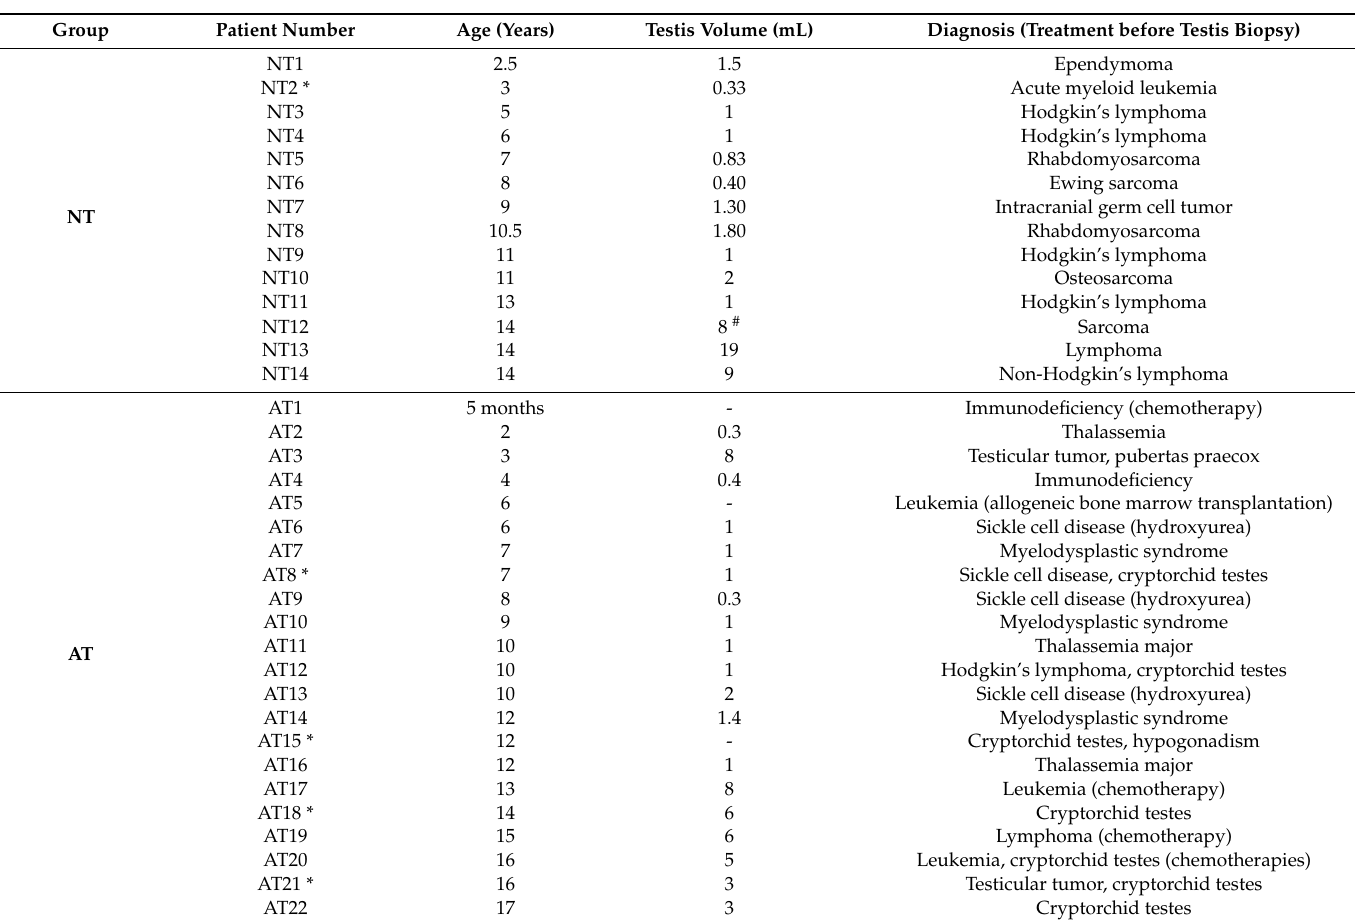
Table 1. Baseline characteristics of the patient cohort. According to diagnosis, treatment received and occurrence of any testicular pathology, patients were divided into two groups: NT: untreated cancer patients without any preexisting (congenital) risk factors for impaired testicular function; AT: patients with potentially a ff ected tissues by disease or treatment. The average age of the patients in NT and AT group is not significantly di ff erent (9.1 and 9.5 years,